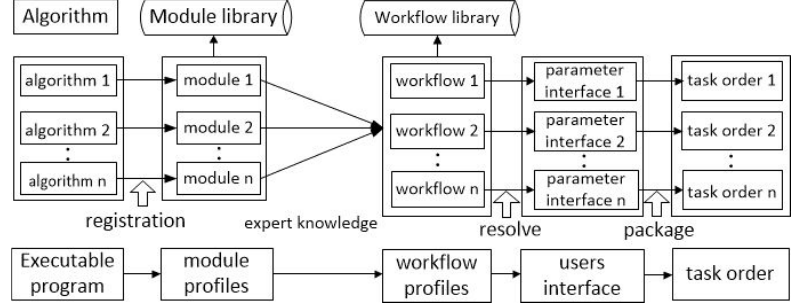
Figure 8. Business process modeling